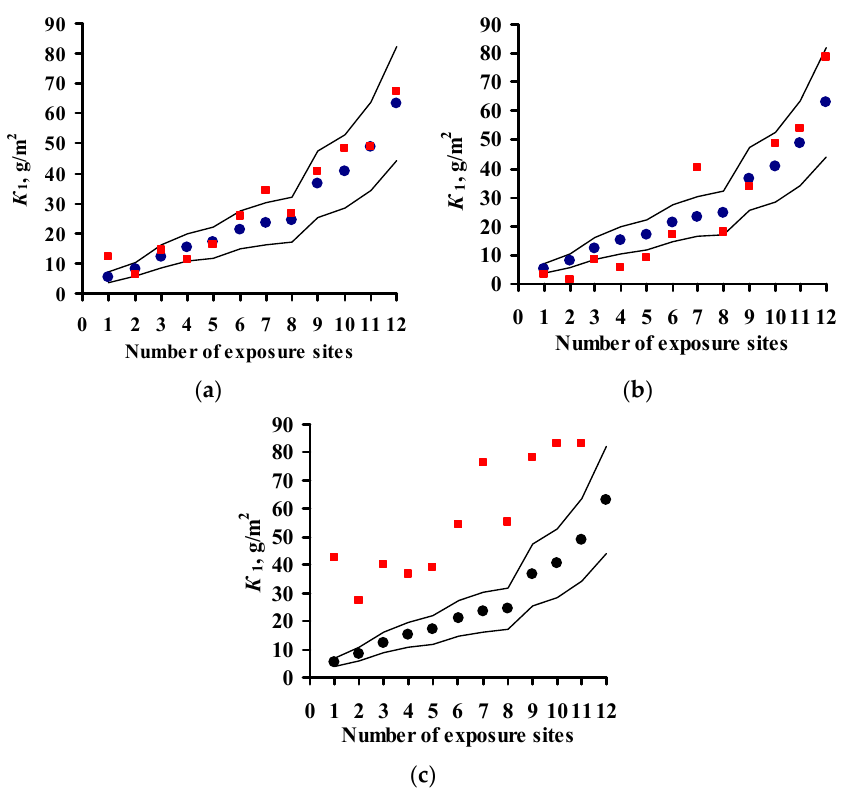
Figure 5. Carbon steel. RF program. K 1 predictions by the New DRF ( а ); Standard DRF ( b ); and Unified DRF ( c ). ● —experimental K 1 data; ■ — K 1 predictions. Thin lines show the calculation error ( ±